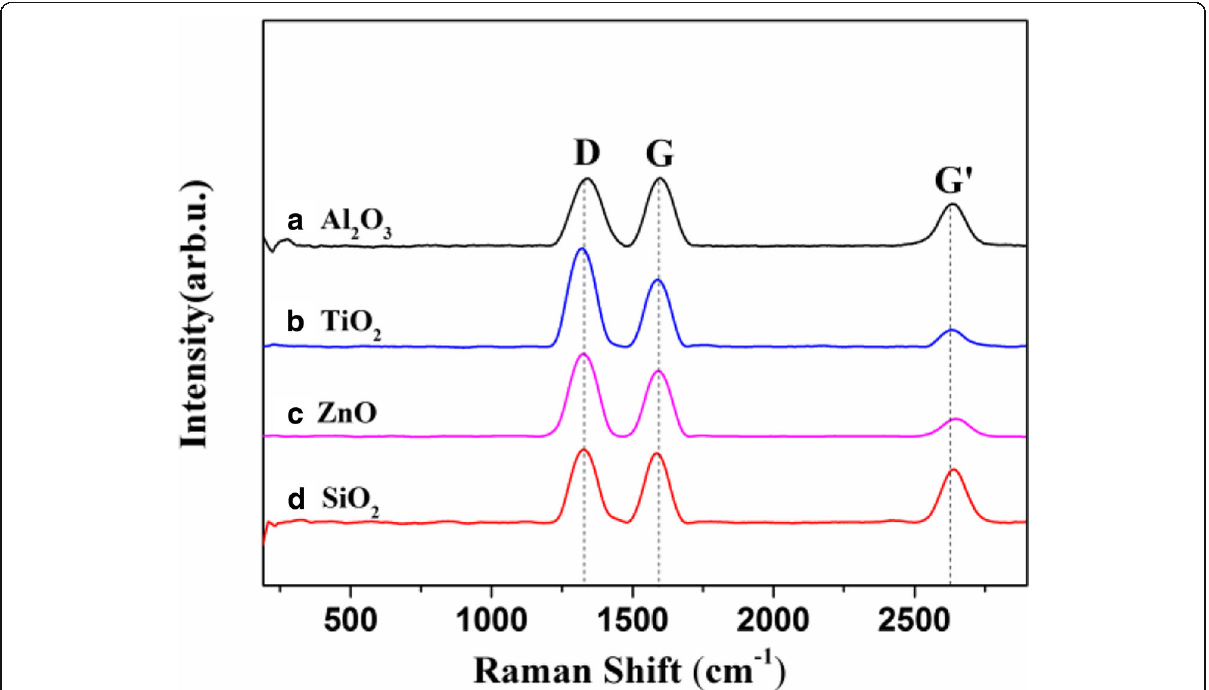
Fig. 4 Raman spectra of VACNTs grown on different buffer layers at 650 °C: a Al 2 O 3 , b TiO 2 , c ZnO, and d SiO 2 . The spectra have been normalized to the intensity of the G band in order to facilitate